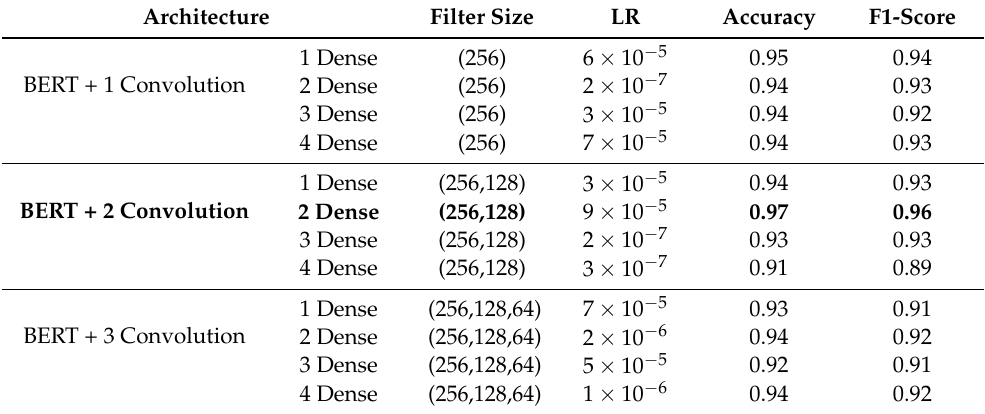
Table 7. The impact of the number of convolution and dense layers on fine-tuning ClaimsBERT. The bold row indicates best model parameters with highest accuracy.